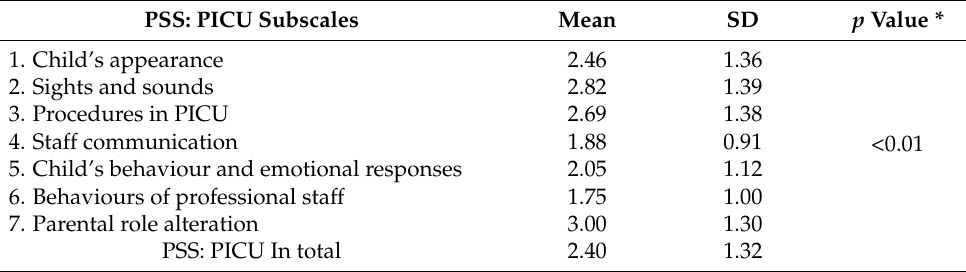
Table 2. Level of perceived stress of parents according to the PSS: PICU